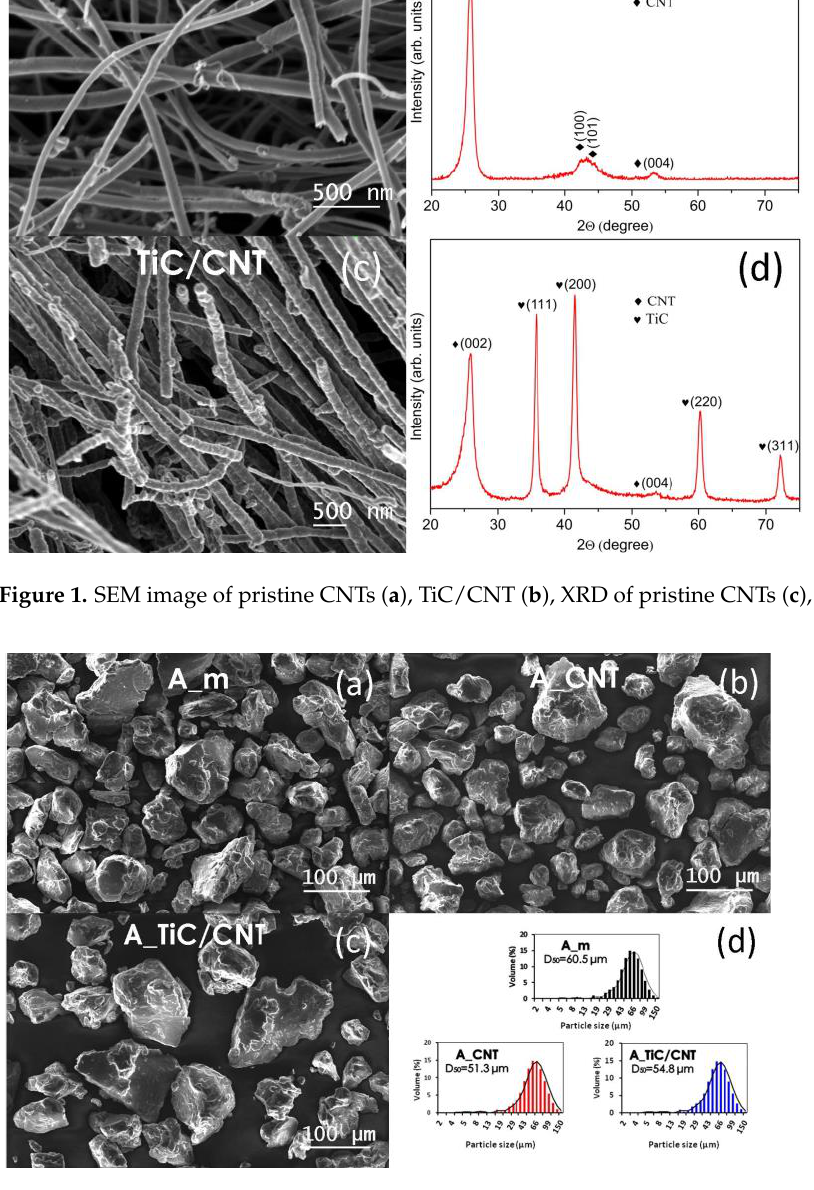
Figure 3. XRD data of powder materials ( a ), bulk samples ( b ) and Raman spectroscopy results of bulk samples ( c ). In addition, it can be noted that the FWHM for bulk samples decreases compared to powder samples. This indicates an increase in crystallite size during isothermal holding during consolidation. For composite samples A_CNT and A_TiC/CNT containing reinforcing nanostructures, a smaller increase of crystallite size was observed in comparison to A_m without reinforcing additives. This may indicate the anchoring of grain boundaries in the composite materials due to reinforcing nanoparticles. Moreover, A_TiC/CNT samples are characterized by a smaller crystallite size both after ball milling